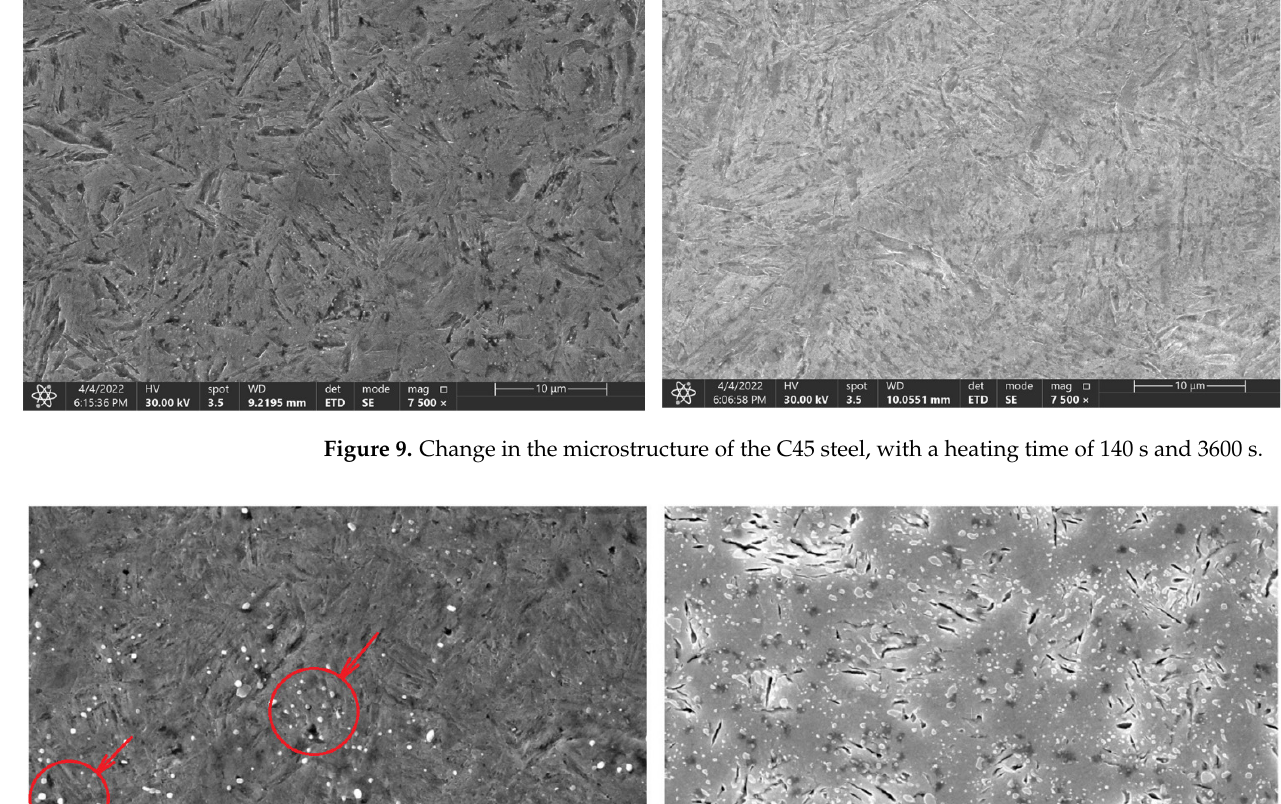
Figure 10. Change in the microstructure of the 80CrV5 steel, with a heating time of 140 s and 3600 s. Areas with chromium carbides are marked in the figure.